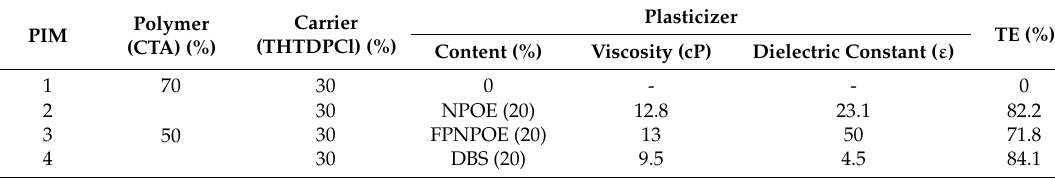
Table 1. Effect of PIM (polymer inclusion membrane) composition on Cd transport efficiency (24 h) and the characteristics of the plasticizers used to prepare the membranes. Feed phase: 10 mg L − 1 . Stripping phase: ultra-pure